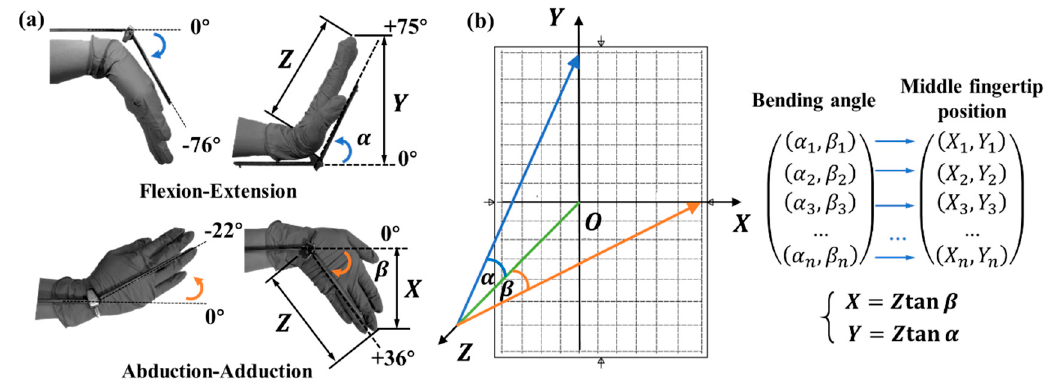
Figure 4. ( a ) Schematic illustration of wrist motion angle detection. ( b ) The transformation of the spatial angle of wrist motion to the plane coordinate ( X , Y ).